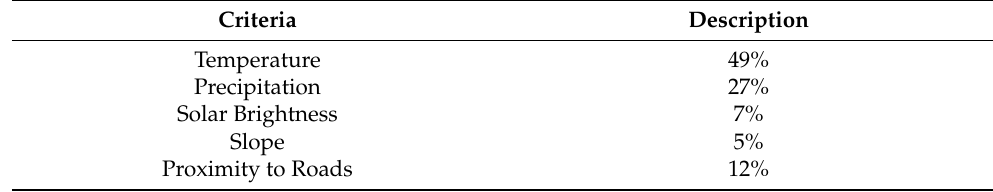
Table 6. Eigenvector of the percentage of influence of criteria in the Hass avocado suitability study.